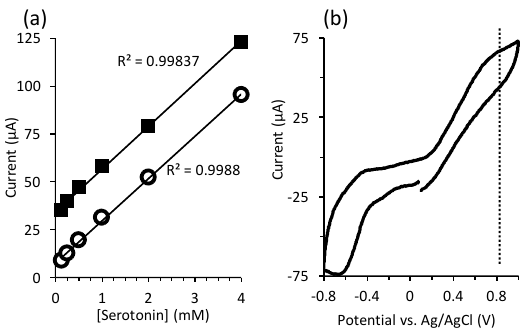
Figure 4. (a) Linearity of detected current in the case of serotonin with concentrationsdownto0.125 mM using cyclicvoltammetry (solid squares) with Figure 12. ( a ) Linearity of detected current in the case of serotonin with concentrations down to 0.125 mM using cyclic voltammetry (solid squares) with scan rate 150 mV/s and chronoamperometry (open circles); error bars in ( a ) were smaller than the data points; ( b ) CV curve of 8 mM of serotonin in human blood plasma. Scan rate : 150 mV/s. The vertical line (dashed) shows the position of the peak that was analysed in ( a